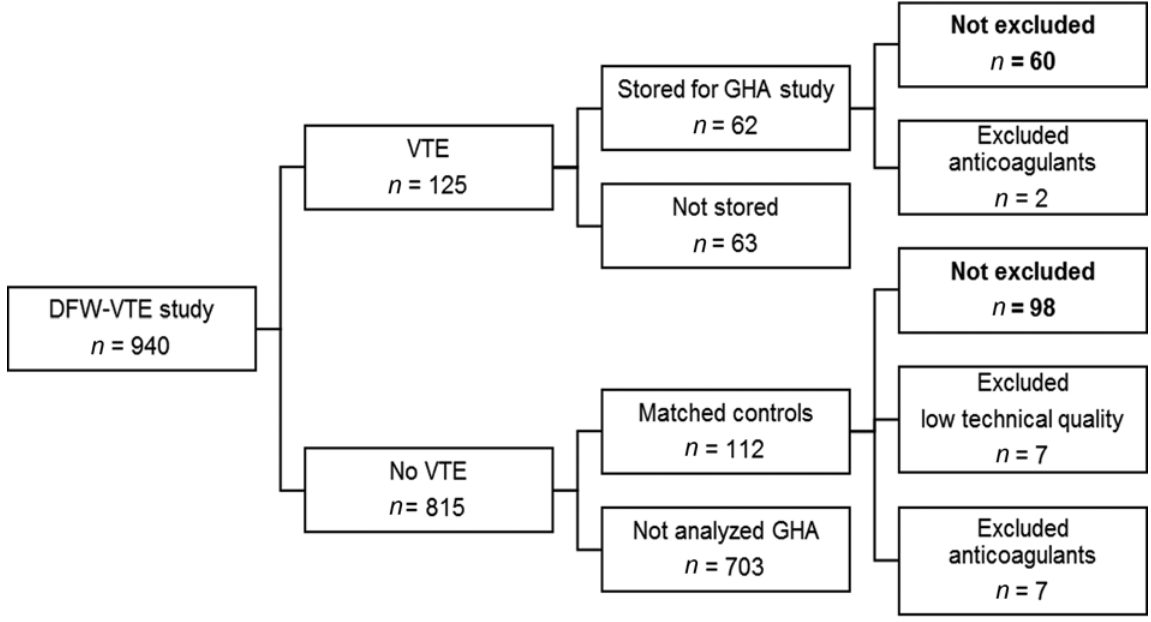
Fig. 1 Flowchart of study samples. Matched controls were selected for all patients with venous thromboembolism (VTE). Only a subset of the 940 samples could be stored in the acute clinical chemistry laboratory. All included samples ( n ¼ 174) were analyzed by overall hemostatic potential (OHP) and endogenous thrombin potential (ETP). Nine patients were excluded due to prior anticoagulant treatment and seven due to low technical quality. Primary analysis in this study was performed on 60 samples with VTE and 98 without